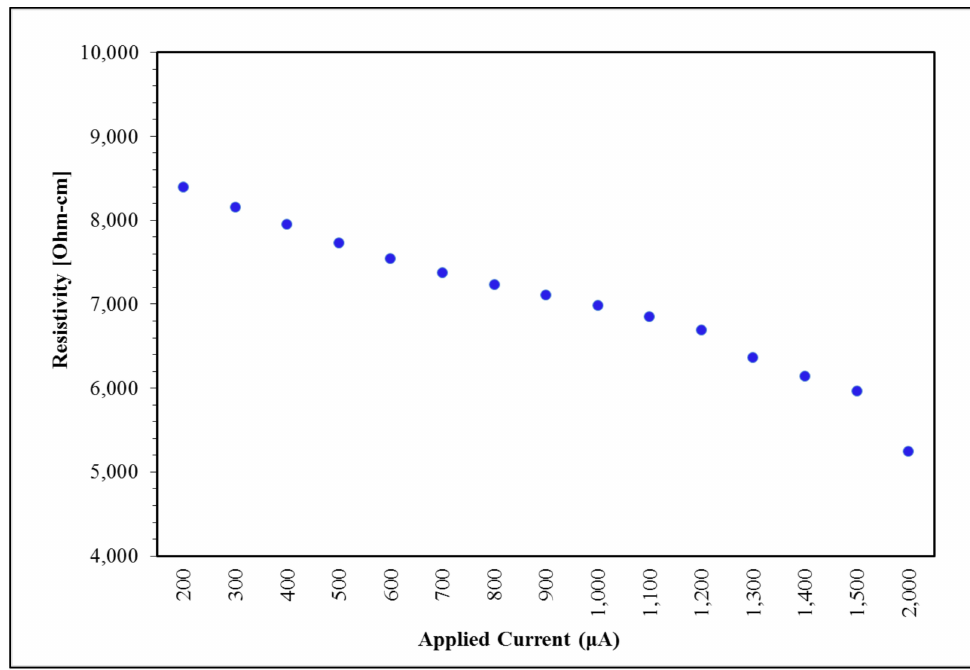
Figure 7. Applied current impact on resistivity at 0.014% wt CNT